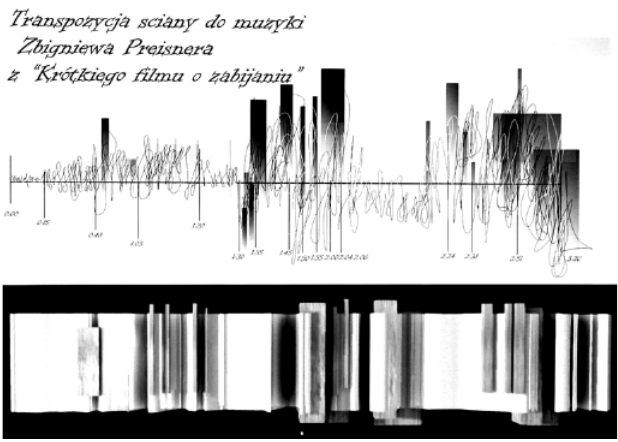
Fig. 5: B. Dzieruk, A Graph of Feelings ,